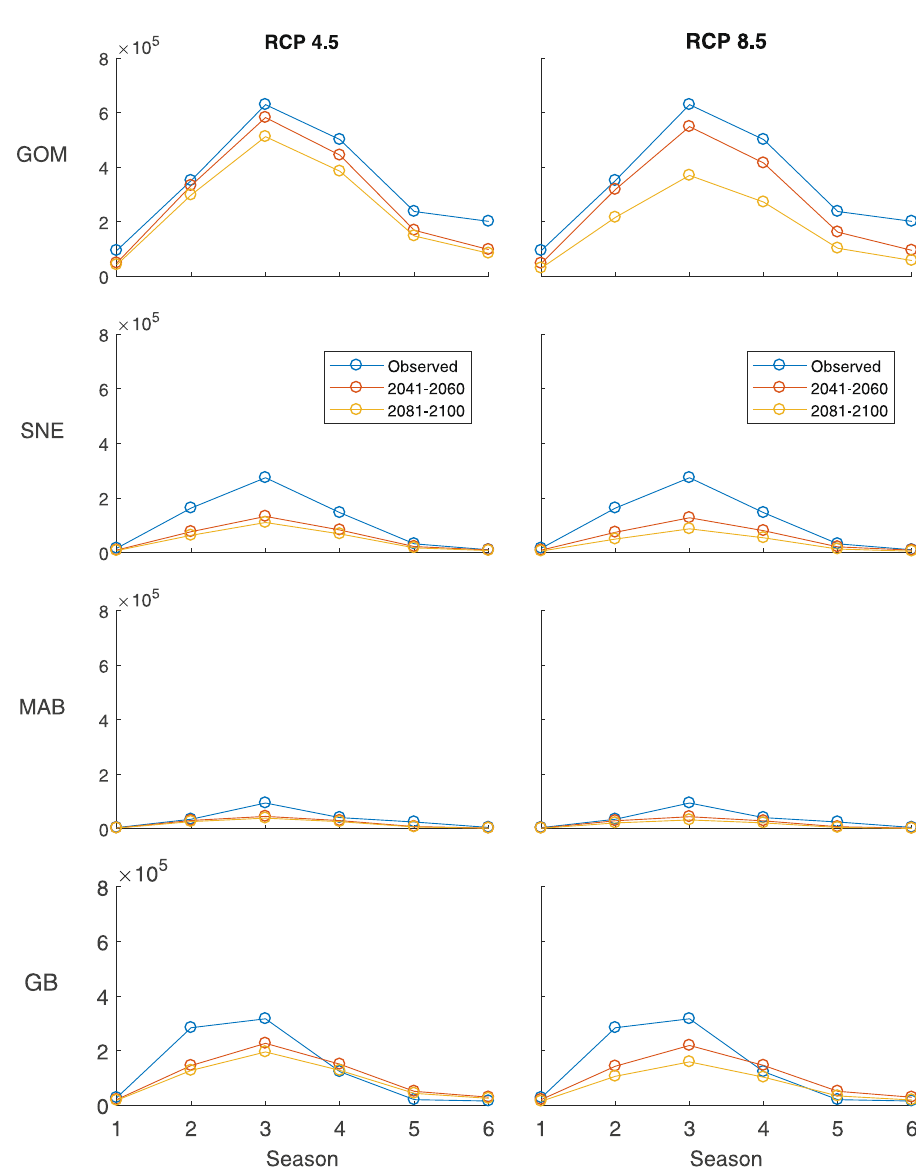
Figure 4. C . finmarchicus density (n/100 m 3 ) in different regions, seasons, and RCP scenarios. The blue points are samples surveyed 1975–2013. Orange and yellow points are densities projected by the ensemble of climate